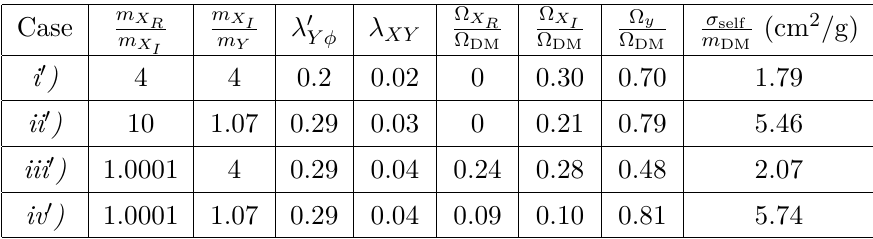
= 37 . 5 MeV, m Y Z 0